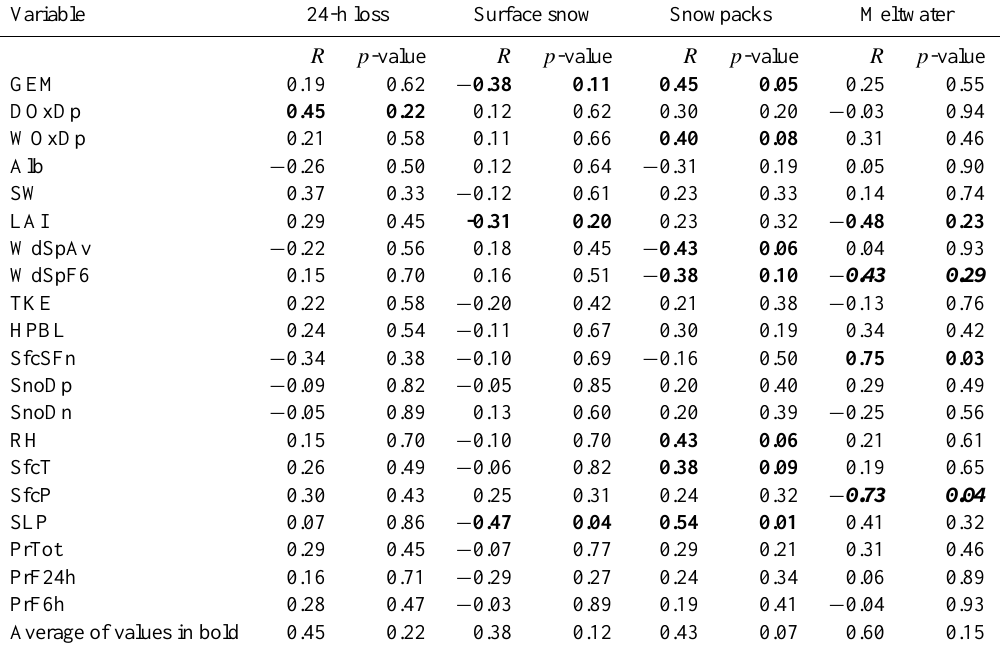
Table 9. Results of bivariate linear regressions for Set1. Bold font indicates parameters that are sufficiently strongly ( | R |≥ 0.35) and signifi- cantly ( p -value ≤ 0.30) correlated; italics indicate falsely correlated